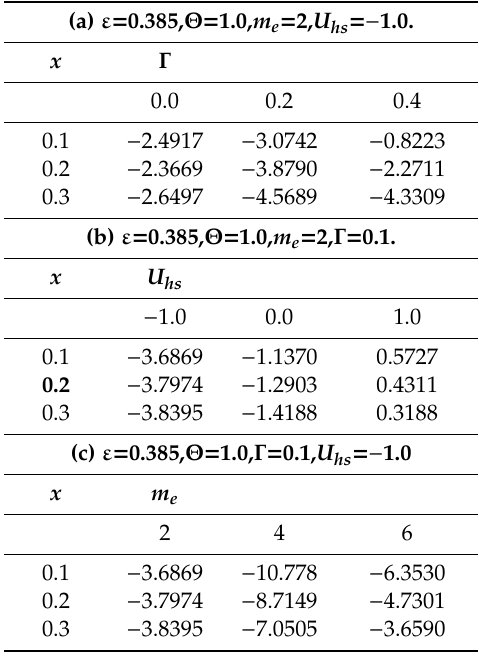
Table 1. Numerical values of shear stress at the wall y = 1 + ε sin x for di ff erent values of